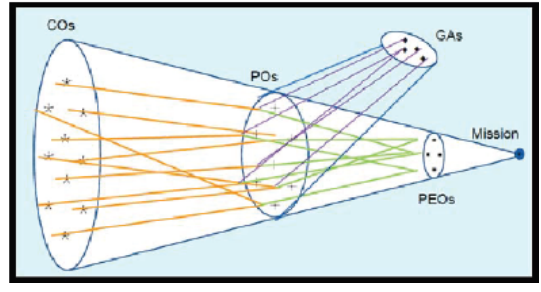
Figure 1. Interlation between co,pos and peo [3]